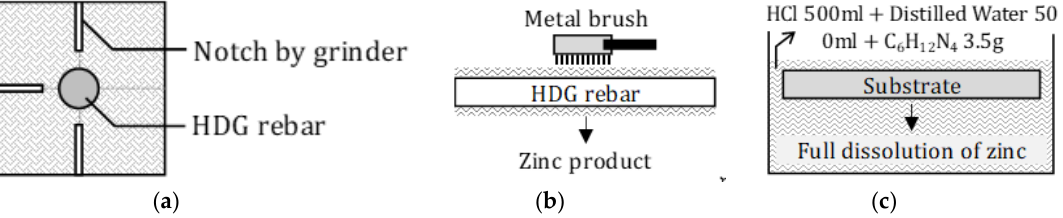
Figure 5. Specimen Treatment for Measuring the Remaining Coating Thickness. ( a ) Concrete cutting; ( b ) removing the zinc product and concrete on the surface (before measuring W 1 ); ( c ) removal of the remaining zinc coating on the substrate (before measuring W 2 ).